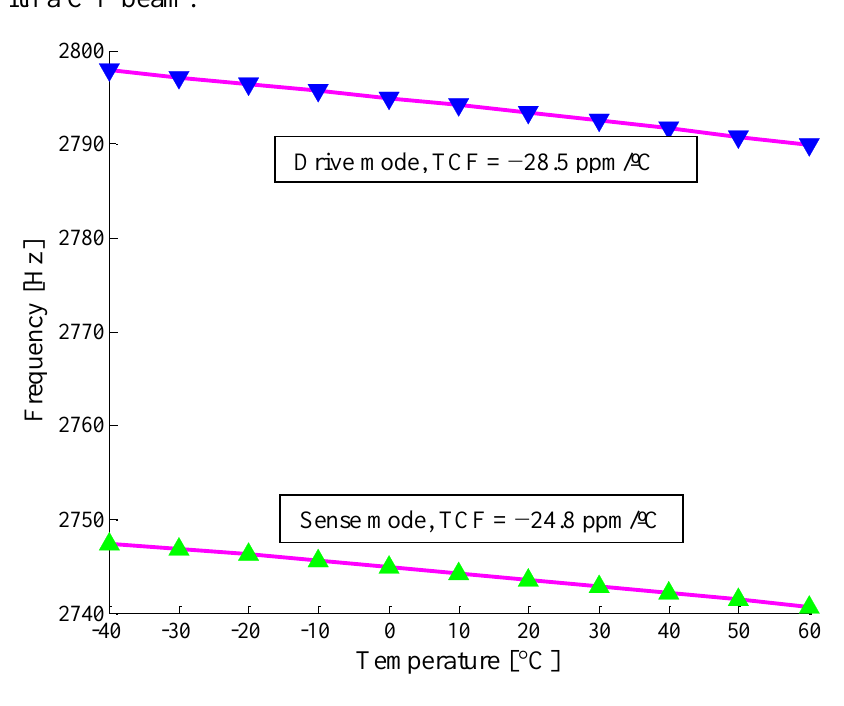
Figure 12. Temperature coefficients of the resonant frequency of the second type gyroscope suspended with a C-C